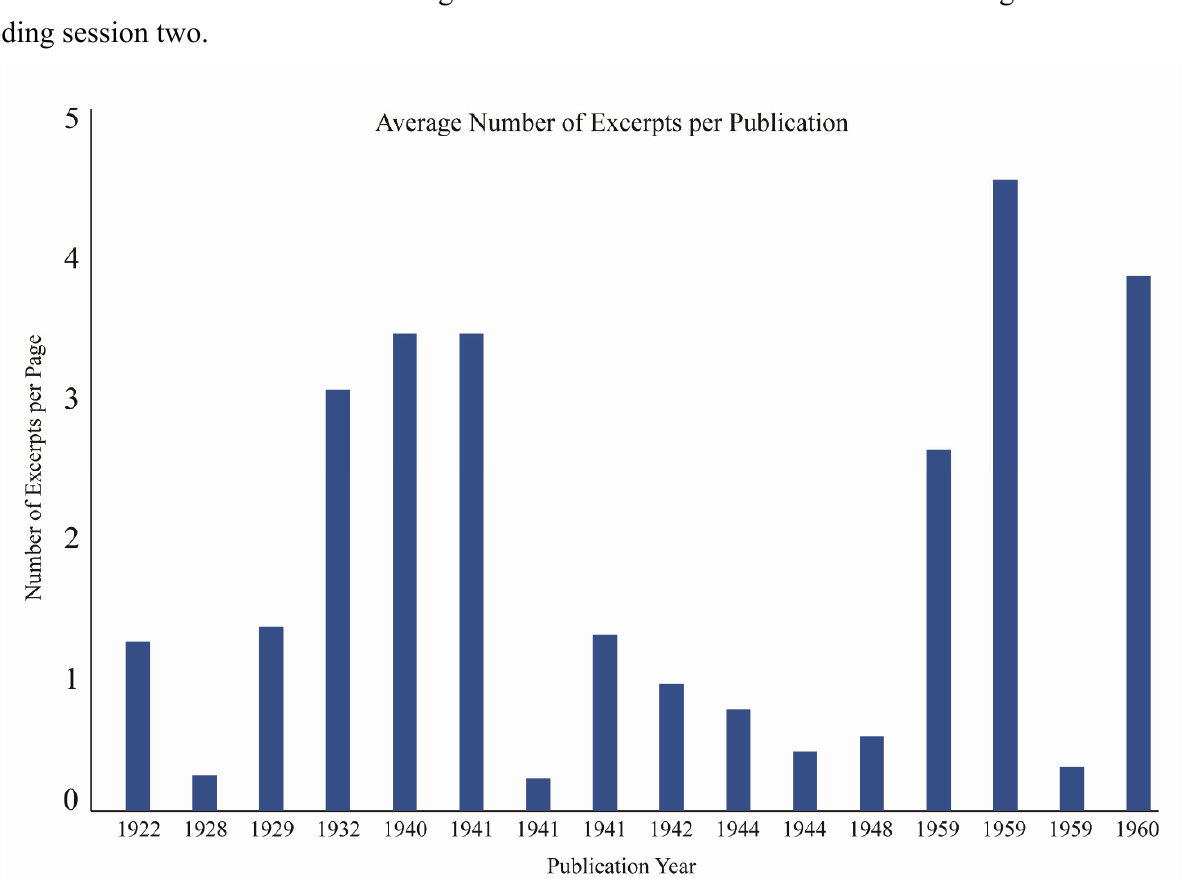
Figure 2. The average number of excerpts extracts per page from the texts, ordered by the text’s publication year. The texts are listed in the same order as provided in Table 4